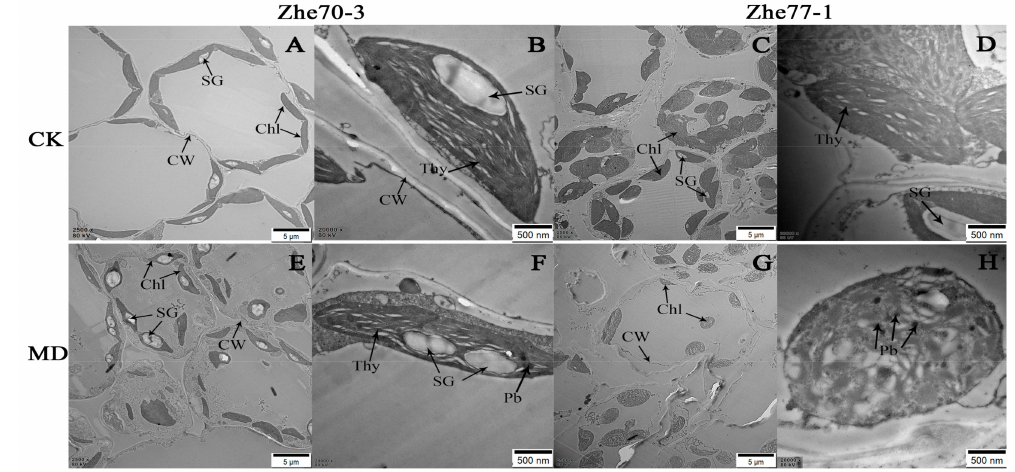
Figure 1. Electron micrographs of leaf mesophyll of Zhe70-3 and Zhe77-1. Plants were exposed to 0 and 1.5 mM Cr stress. ( A – D ): TEM micrographs of leaf mesophyll cells of Zhe70-3 and Zhe77-1 under control with low and high magnifications; ( E – H ): TEM micrographs of leaf mesophyll cells of Zhe77-1 under 1.5 mM Cr with low and high magnification. Thy: thylakoid, SG: starch grains, Chl: chloroplast, CW: cell wall, Pb: